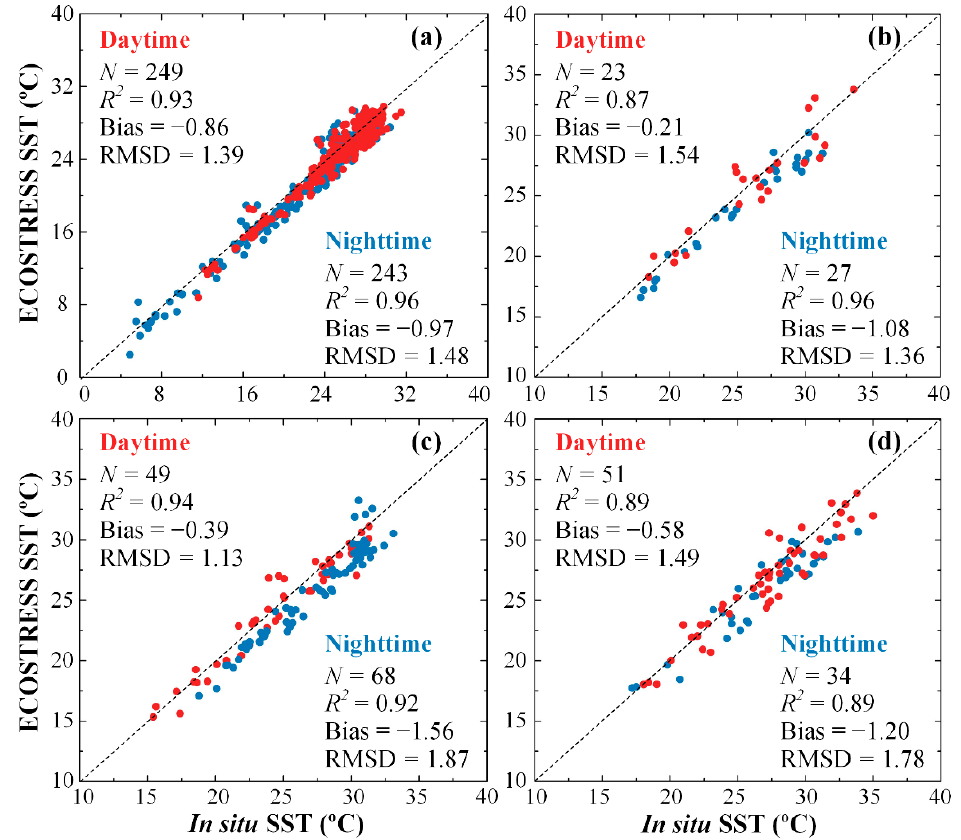
Figure 2. Comparison between in situ SST and ECOSTRESS SST in ( a ) CB, ( b ) LO, ( c ) CRE, and ( d ) FB from the matching pairs found between August 2018 and August 2020. The dotted lines are the 1:1 lines. Daytime and nighttime data are color-coded in red and blue, respectively. Table 2. Statistics of the matchup pairs between in situ SST and ECOSTRESS/MODIS SST from Au- gust 2018 to August 2020. Here, “Area” represents estuary or lake name. The time column indicates whether the data is collected in the daytime, or nighttime, or a combination of both (local time). N is the number of matching pairs, R 2 is the coefficient of determination, slope and Intercept are the linear regression coefficients between the two data sets, bias represents the mean absolute deviation in the ECOSRESS/MODIS data, and RMSD is the root mean square difference.